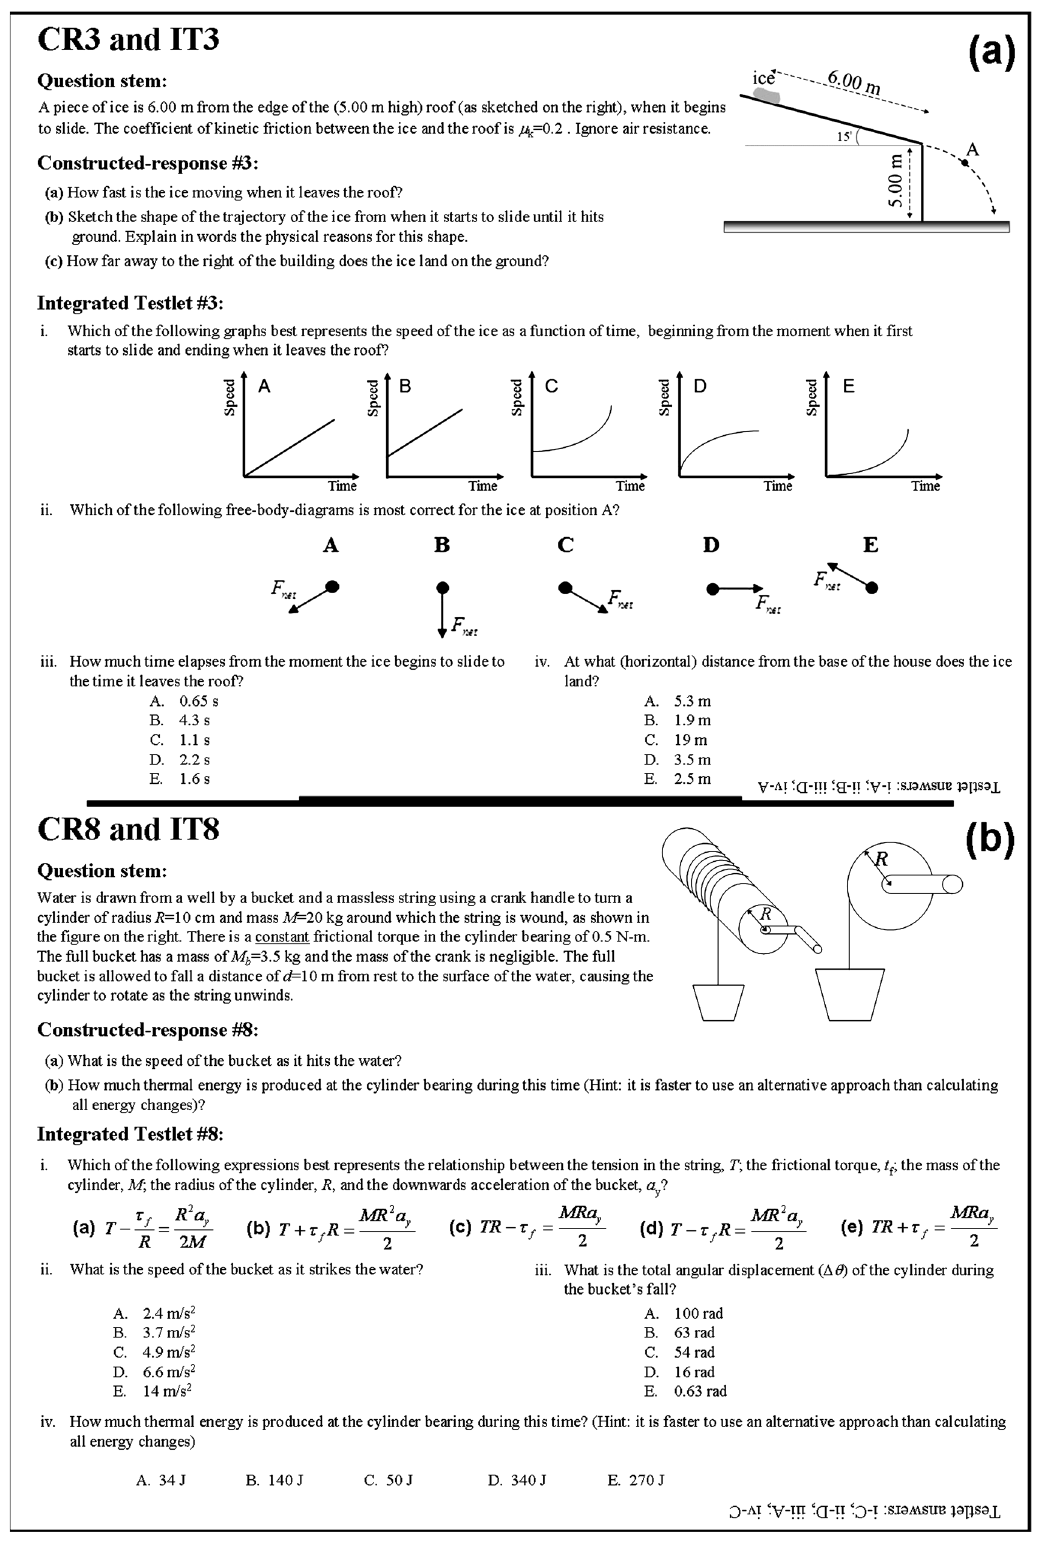
FIG. 1. Examples of concept-equivalent constructed-response and integrated testlet questions. Integrated testlets comprise a set of MC items with varying levels of integration. The CR and IT questions share a common stimulus, and the final multiple-choice item in the IT is the same as the final CR subquestion. (a) CR3 and IT3 are examples from the midterm exam and cover concepts such as 2D projectile motion and kinetic friction. (b) CR8 and IT8 are examples from the final exam and cover concepts such as rotational motion, torque, and work. Note that IT8-iii exists to cue students to the most efficient means of solving IT8-iv. By contrast, such cuing is absent in